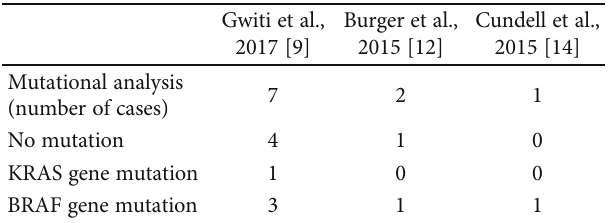
Table 2: Summary of gene mutations described in the serous borderline tumor of the